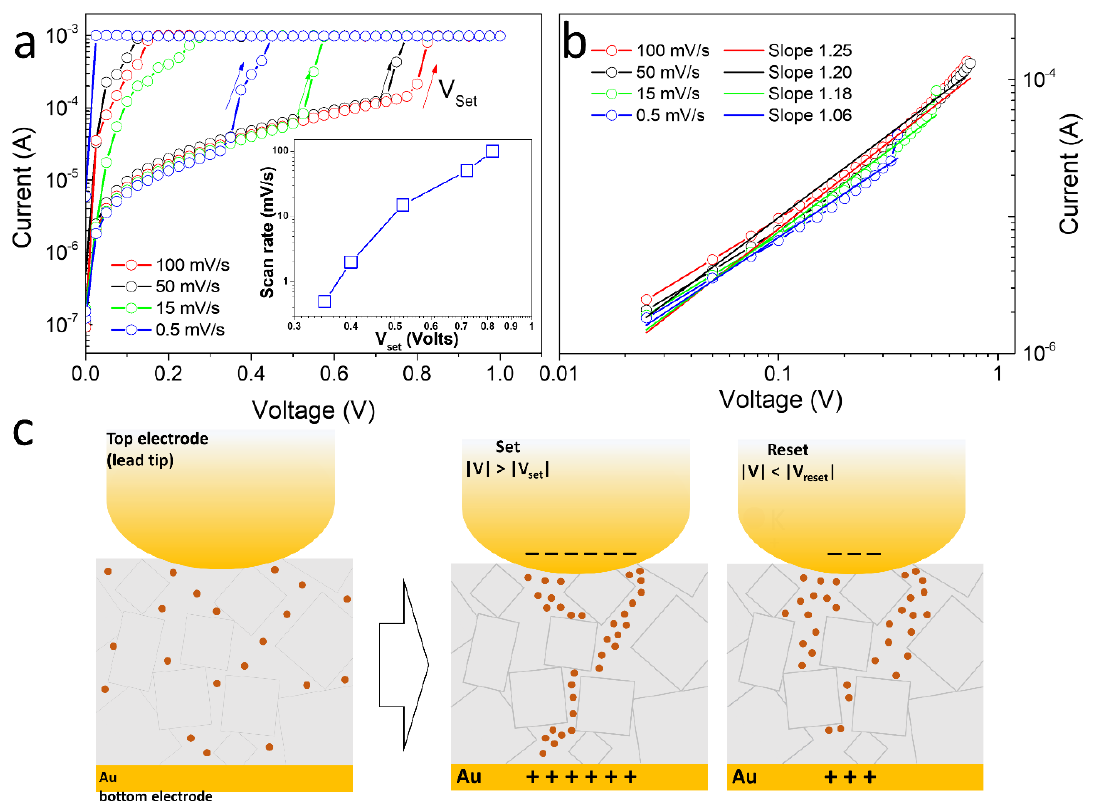
Figure 5. ( a ) 𝐼 (cid:3400) 𝑉 curves in the positive bias voltage range measured with different potential scan rates. The inset shows the 𝑉 (cid:3046)(cid:3032)(cid:3047) as a function of the potential scan rate. ( b ) Log–log scale curves of the HRS state, below 𝑉 (cid:3046)(cid:3032)(cid:3047) . ( c ) Schematic dia ‐ gram of metallic filament formation of defects among crystals and free ions dispersed in the PW